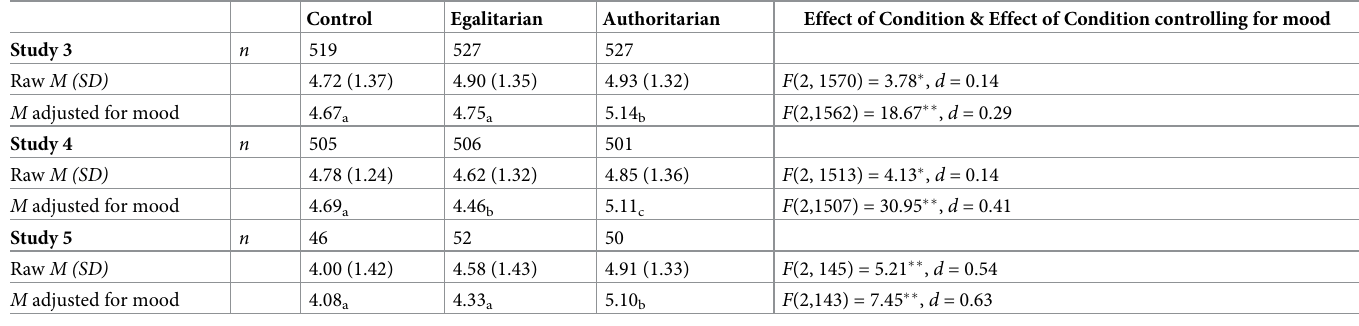
Table 4. Effects of condition on meaning in life, Studies 3, 4, and